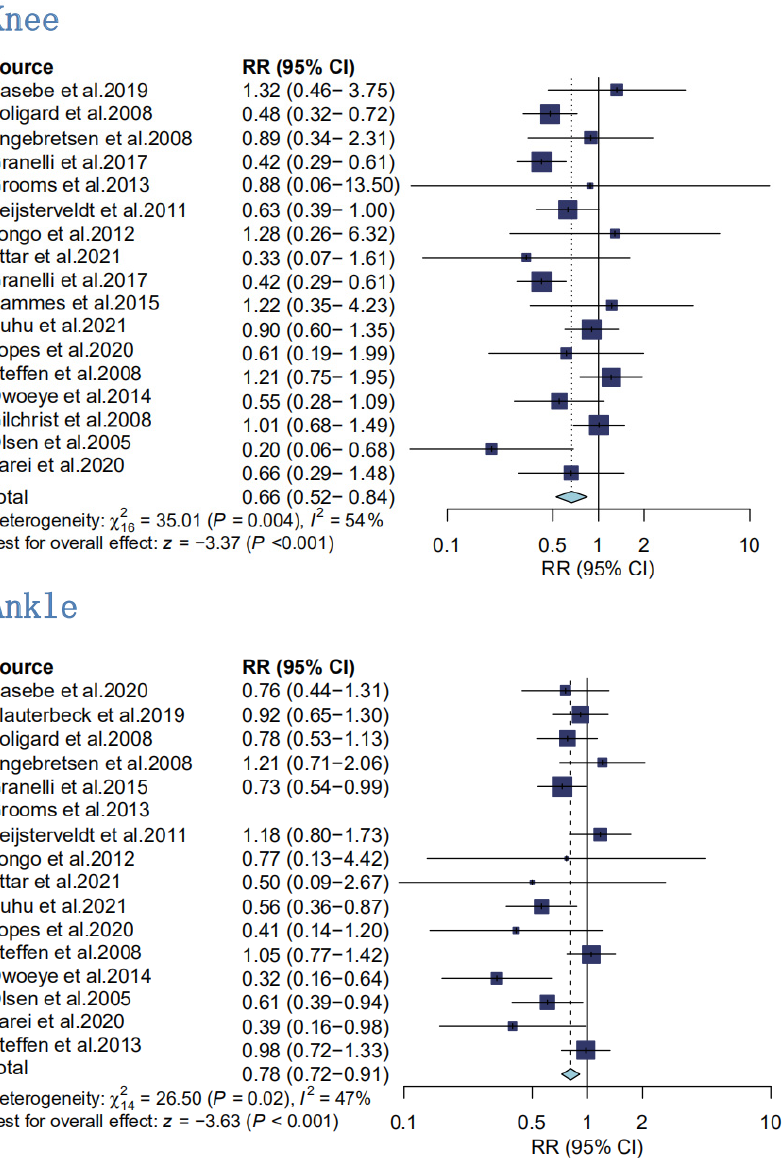
Figure 6. Secondary analyses of injury rates in hamstring eccentric exercise prevention programs compared with control intervention for the following specific body regions: knee and ankle [4,5,18,19,22,27,39 – 47,55 –